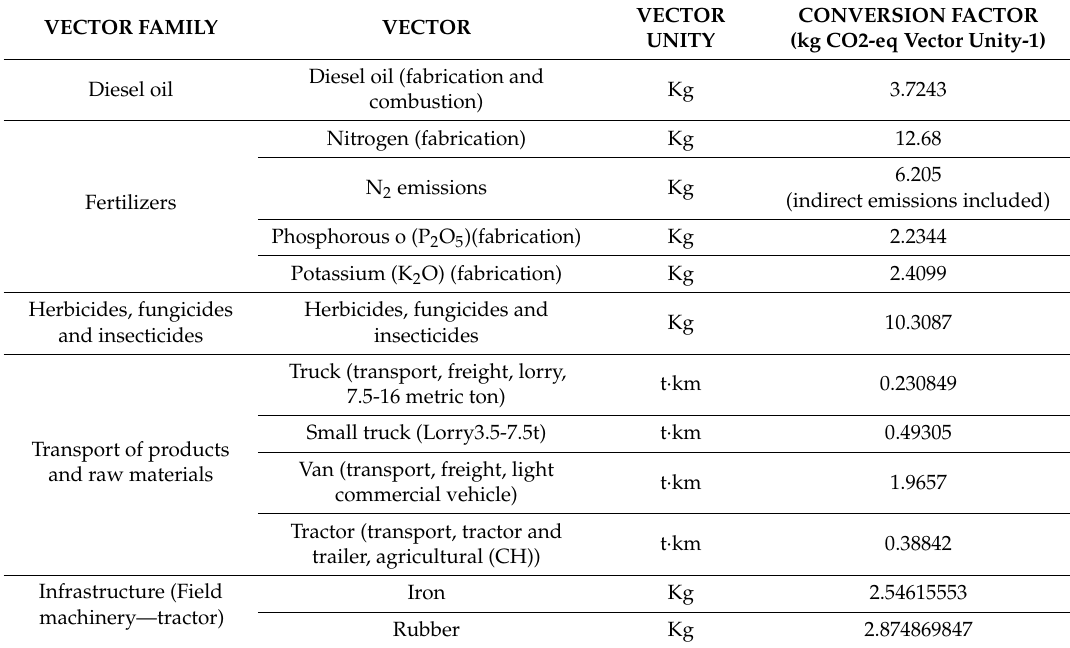
Table 9. Vectors, vectors family and conversion factors used (Ecoinvent